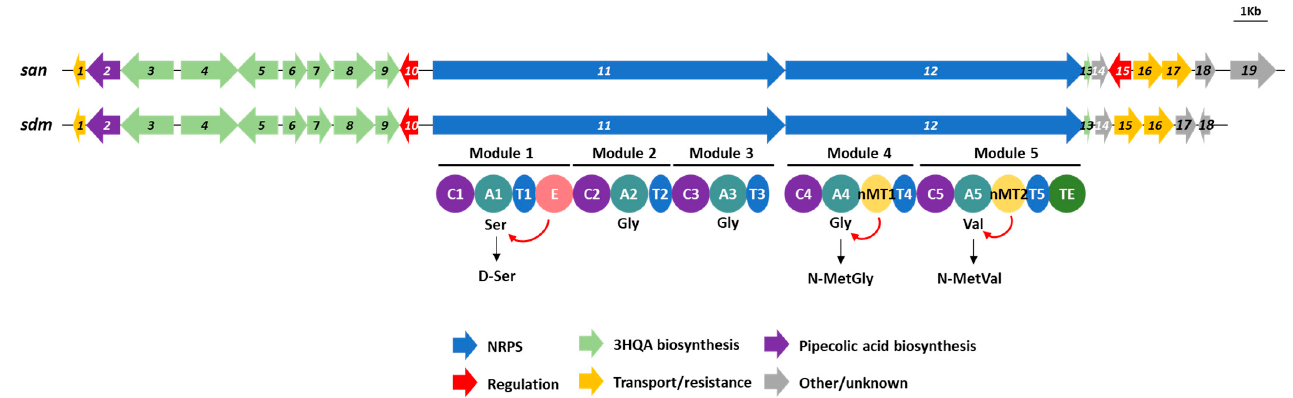
Figure 5. Biosynthetic gene cluster of sandramycin from Kribbella sp. CA-293567 ( san ) and Kribbella sandramycini ATCC 39419 T ( sdm ). The modules and domains present in the NRPS genes ( san11 and san12 ) are depicted. The amino acids proposed to be activated by each adenylation domain and the modifications performed by the E and nMT domains are indicated. (A): adenylation domain; (C): condensation domain; (E): epimerization domain; (nMT): N -methyltransferase domain; (T): thiolation domain; (TE): thioesterase domain.